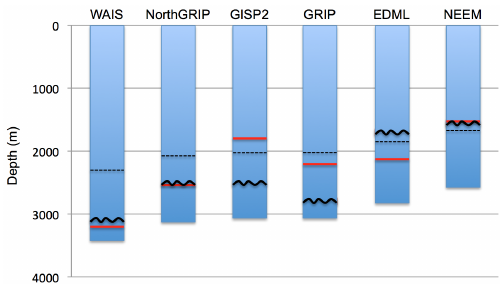
Figure 10. Comparison of the onset of visible folding in ice cores with published visual stratigraphy. The red line indicates single maximum fabric; the black line indicates onset of folding; the dashed black line indicates the lower third of the ice core. Data are from Thorsteinsson (1996) (GRIP), Alley et al. (1997); Gow et al. (1997) (GISP2), Svensson et al. (2005); Wang et al. (2006) (North GRIP), and Faria et al. (2010) (EDML), Fitzpatrick et al. (2014)